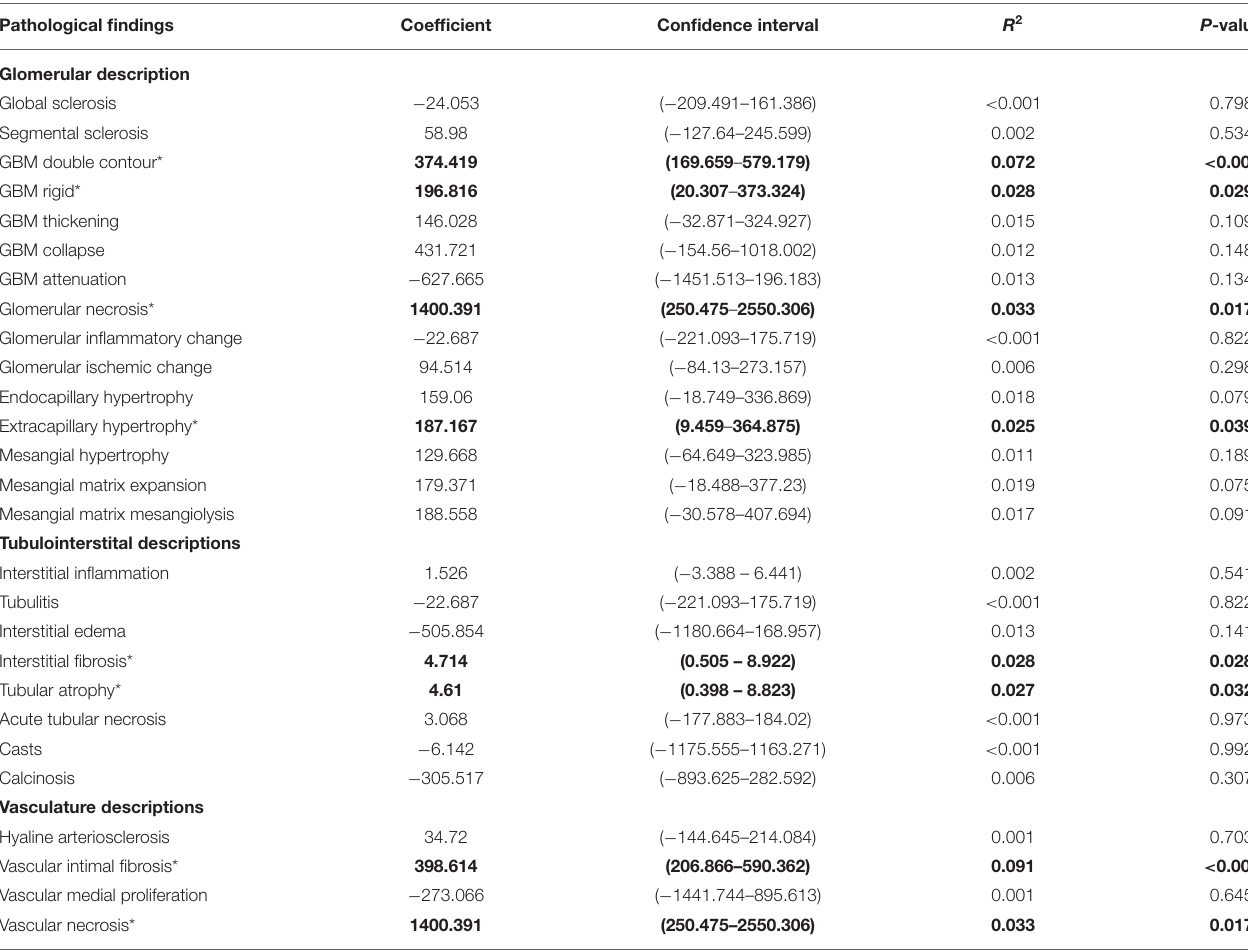
TABLE 2 | Regression for plasma Gal-3 and renal pathological findings. Pathological